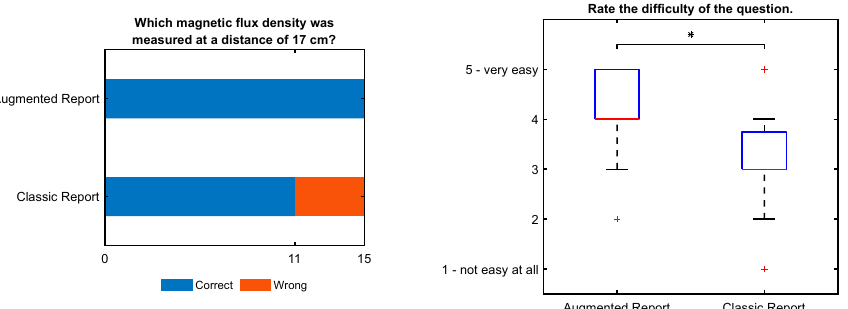
Figure 7. Participants in the “Classic Report” group made mistakes and perceived the question as significantly more difficult (indicated by the star). Six participants of the “AR” group reported that they used the AURA images to answer the question.